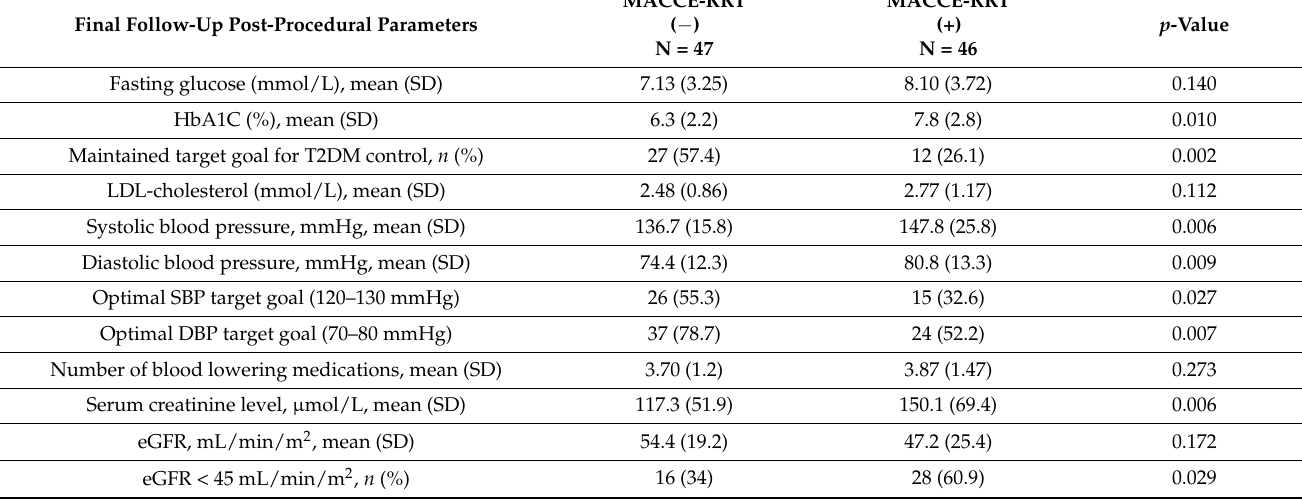
Table 2. Final follow-up post-procedural parameters of blood pressure, renal function, blood lowering medications, glycaemic and biochemical tests, and stent patency in MACCE-RRT (+) vs. MACCE-RRT ( − )